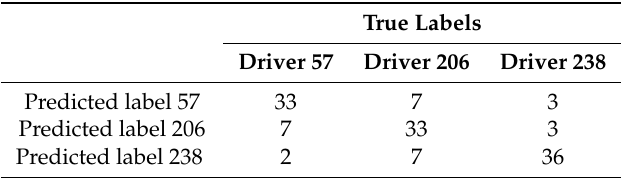
Table 2. Confusion matrix of the out-of-sample analysis of Table 1.